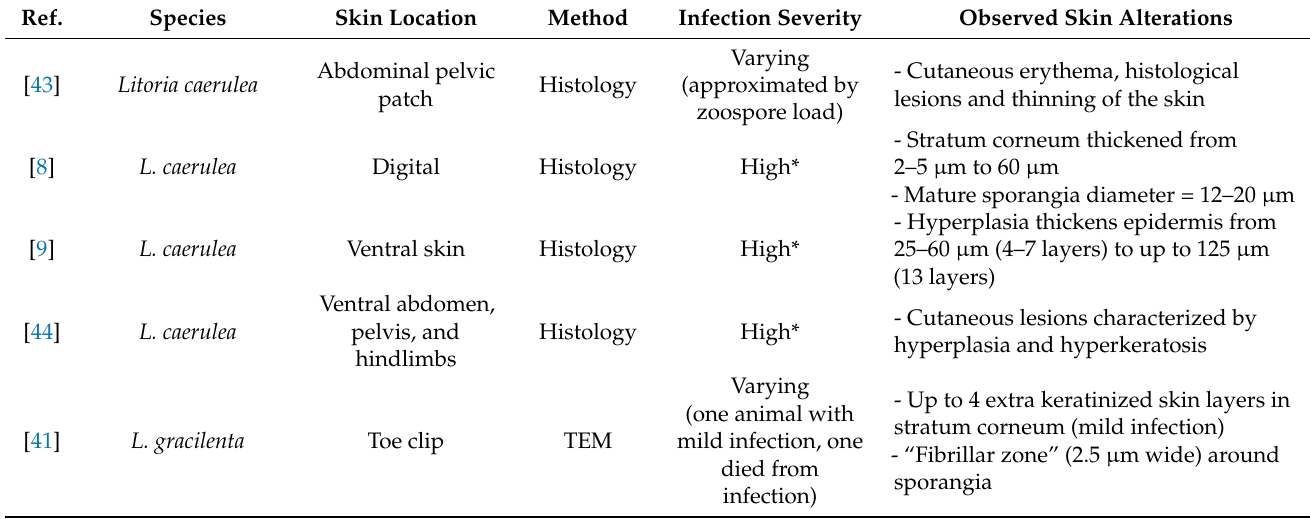
Table 1. Overview of Bd -induced epidermal alterations in hylid tree frogs (top) and other anuran species (bottom).